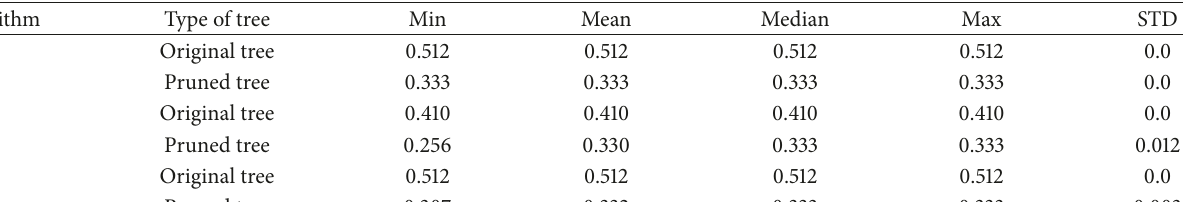
Table 3: Statistics of 51 runs of the reduced error pruning of the CART with 10-fold cross-validation with ICA, PCA, and SVD data reduction algorithms.